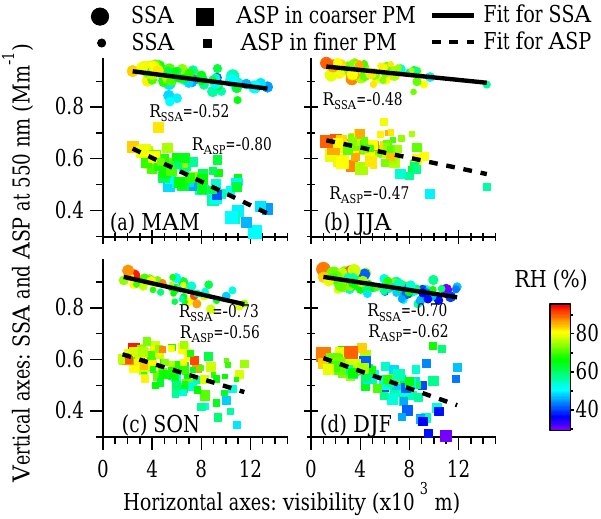
Figure 11. Relationships between SSA and visibility (solid cycles) and between ASP and visibility (solid squares) in different RH and AAE levels in spring (a) , summer (b) , autumn (c) and winter (d) .